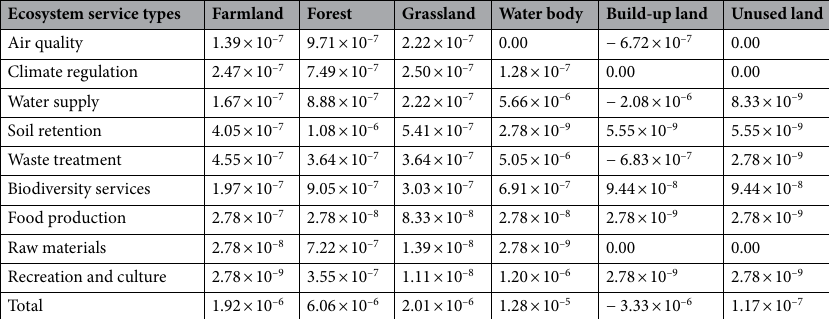
Table 1. The Qinghai’s per-unit value coefficient of ES. Unit: 2020US$ Billion/hm 2 .